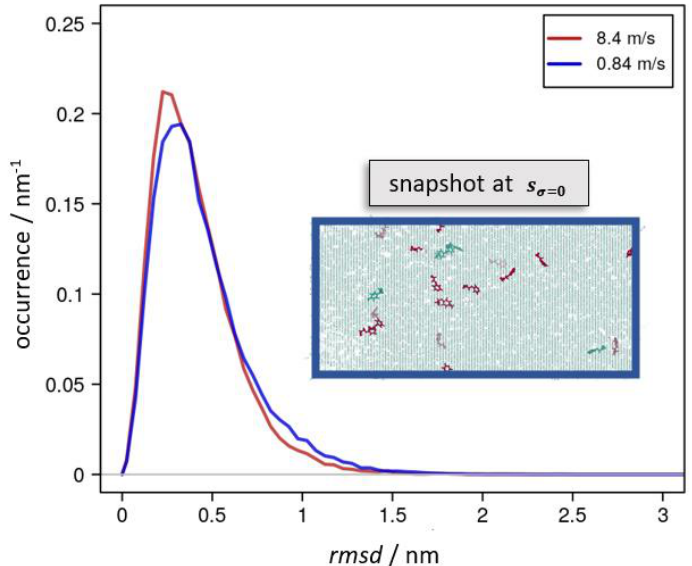
Figure 5. Occurrence profile of the rmsd taken for snapshots taking deformation up to 8.4 nm and the corresponding reversal run. For this, configurations of equal elongation s were chosen according to s = s σ =0 = 6.2 and 6.1 nm, for which the momentary stress reached zero during the reversal runs using 8.4 m∙s − 1 (red curve) and 0.84 m∙s − 1 (blue), respectively. For the latter run, the inset shows the epoxy network highlighting EPON moieties that permanently lost one of its links in the red color. Likewise, the green color indicates EPON species that cleaved and rebuilt covalent bonds to the DEDTA linkers. These findings contradicted the constitutive model that predicts s σ =0 = 0 for